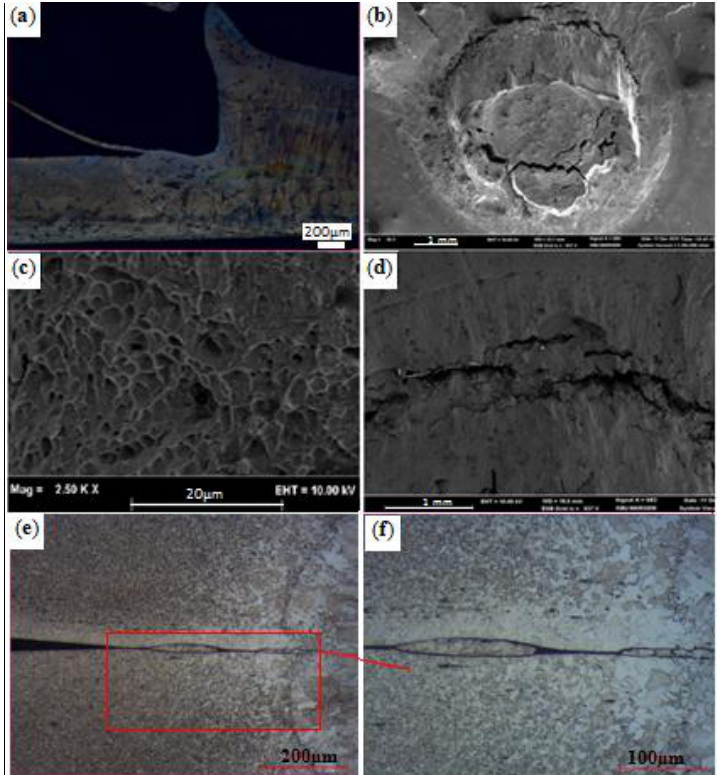
Figure 4. PIF mode of a spot-welded sample: ( a ) PIF; ( b ) macrograph of weldment; ( c ) fracture in weld nugget; ( d ) HAZ; ( e ) microstructure of HAZ; ( f ) high magnification of HAZ microstructure Transition from PIF to PF mode depends on the physical characteristics, strength of the crack initiation zone, and especially the weld nugget sizes [11,27,28]. In this study, the transition from PIF